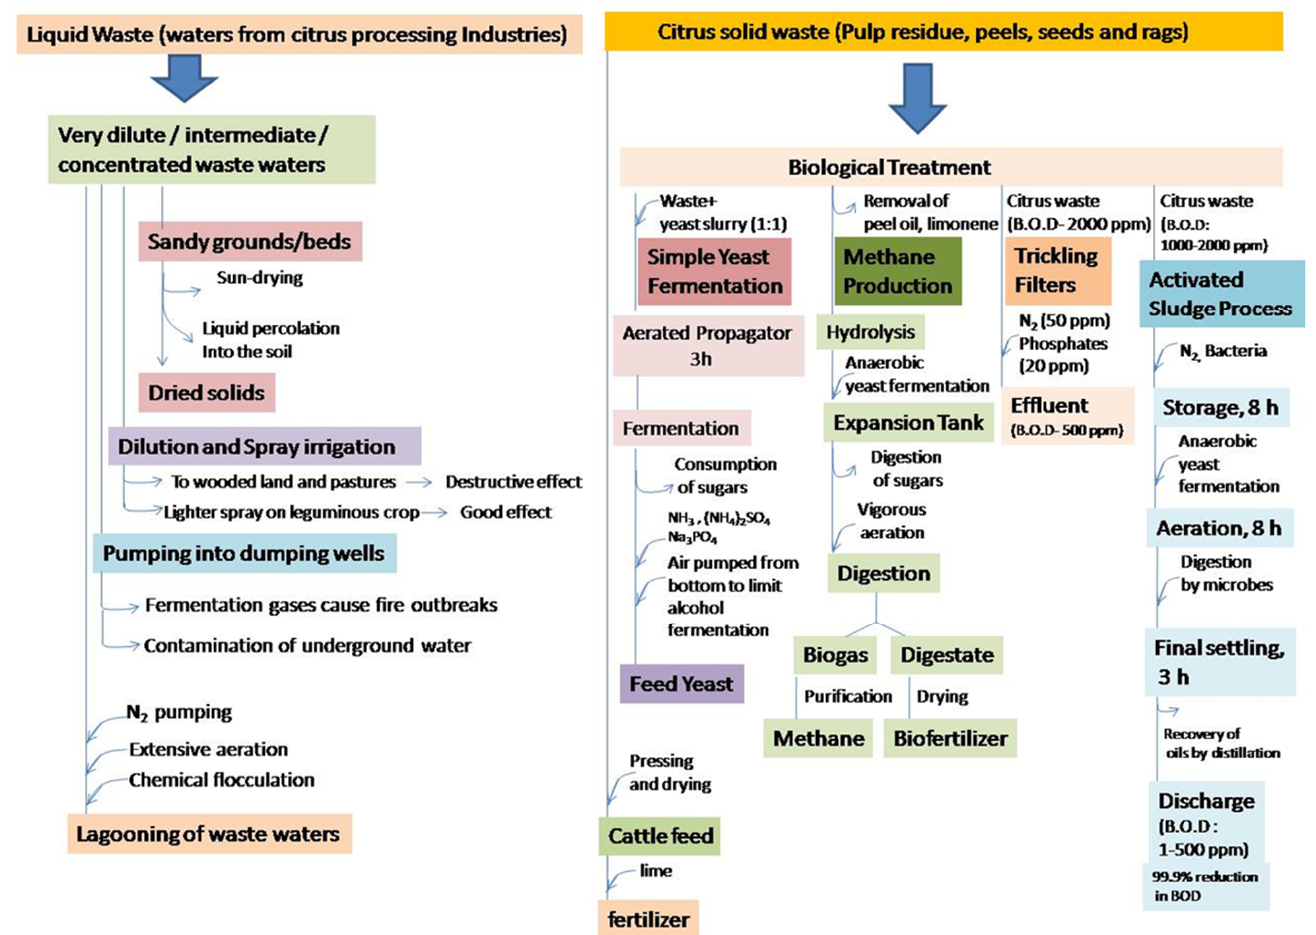
Figure 2. Methods of systematic and environment-friendly disposal of citrus wastes, conversion into useful materials and their relative merits.